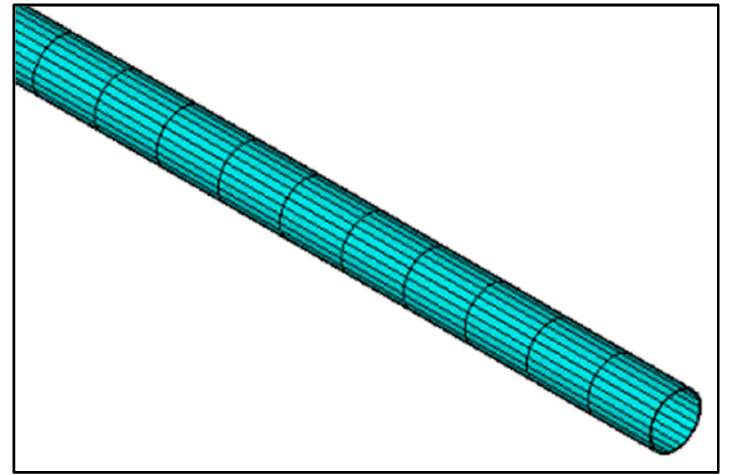
Figure 3. Grid division of pipelines laid across